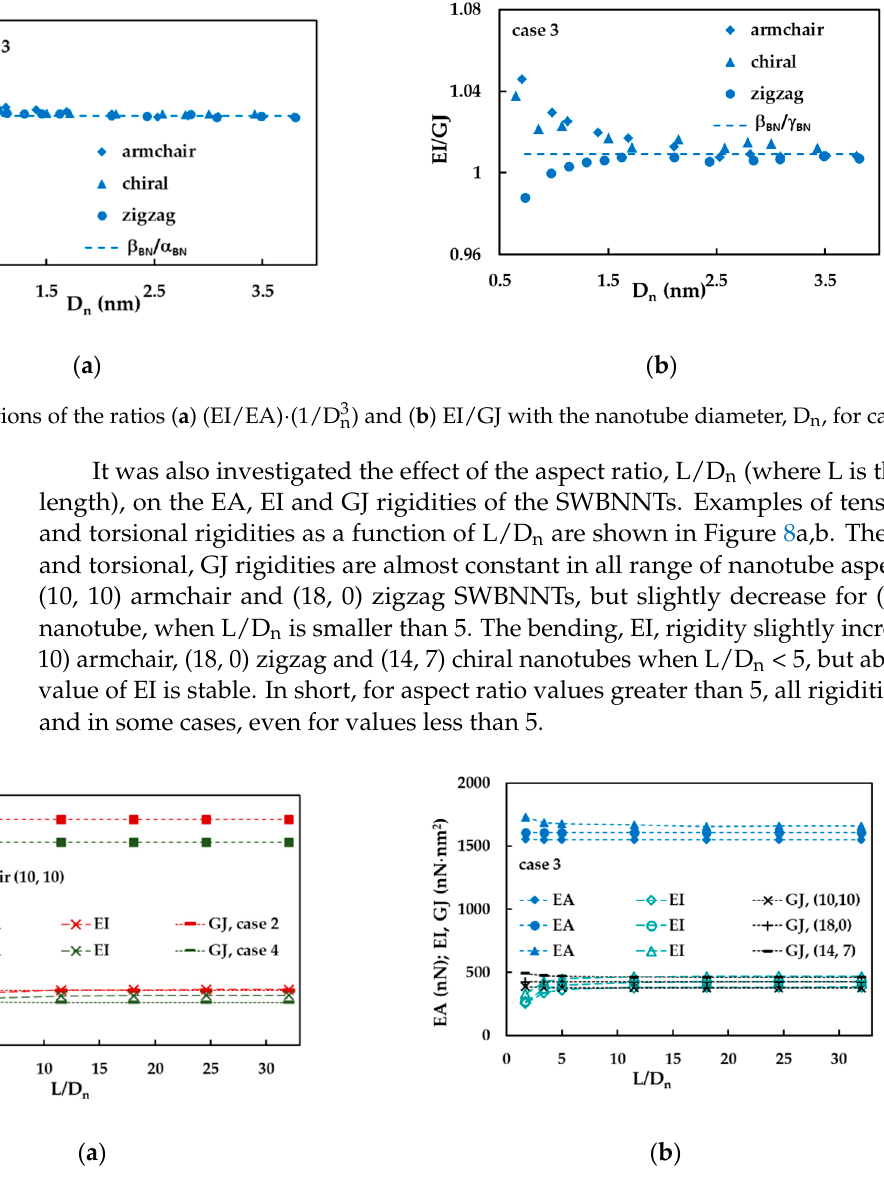
Figure 8. The evolutions of EA, EI and GJ rigidities with the aspect ratio, L/D n , for: ( a ) (10, 10) armchair, cases 2 and 4, and ( b ) (10, 10) armchair, (18, 0) zigzag and (14, 7) chiral nanotubes, case 3.